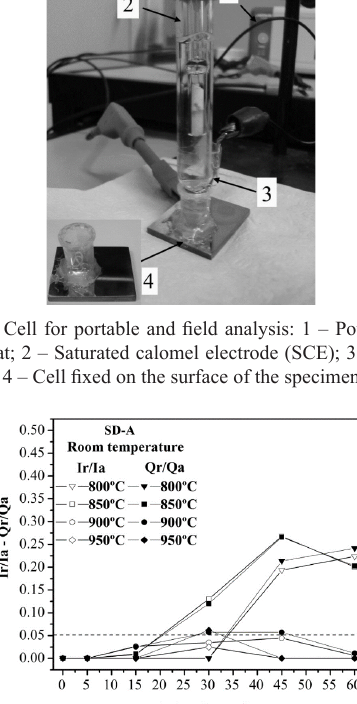
/I and Q /Q versus aging time for SD-A in 2.00 M H r a r a